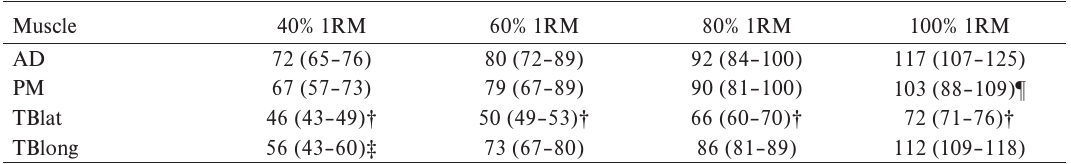
Muscle activity at various exercise intensities as a peak amplitude normalized to maximum voluntary isometric